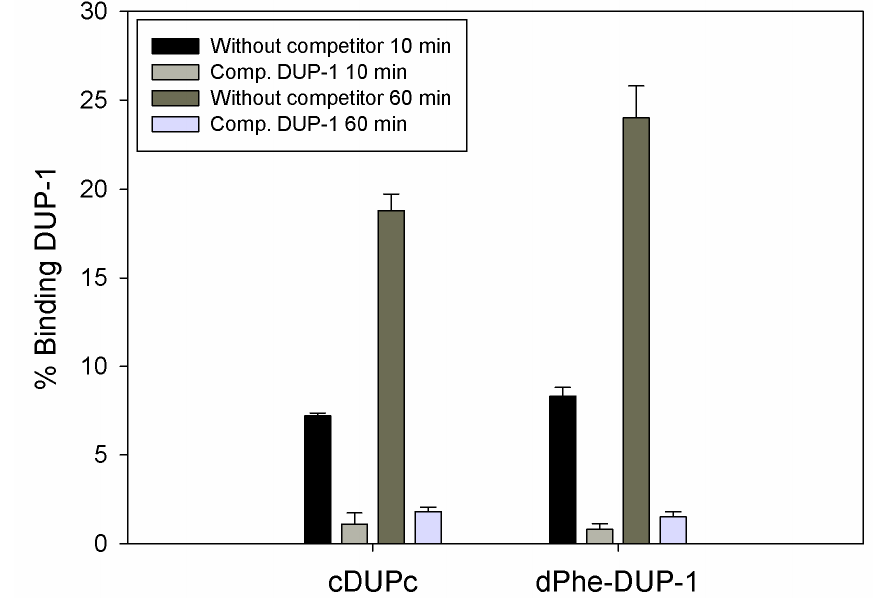
Figure 5. Binding and competition of 125 I-labeled cDUPc and 125 I-labeled dPhe-DUP-1 on prostate carcinoma PC-3 cells. The unlabeled DUP-1 peptide was used as competitor at a concentration of 10 − 4 M.